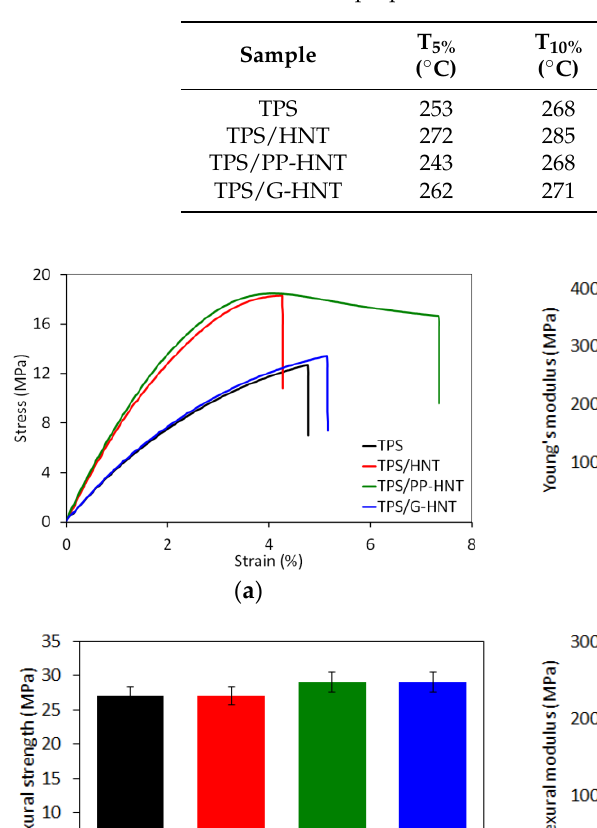
Table 4. Thermal properties of unmodified and modified TPS.